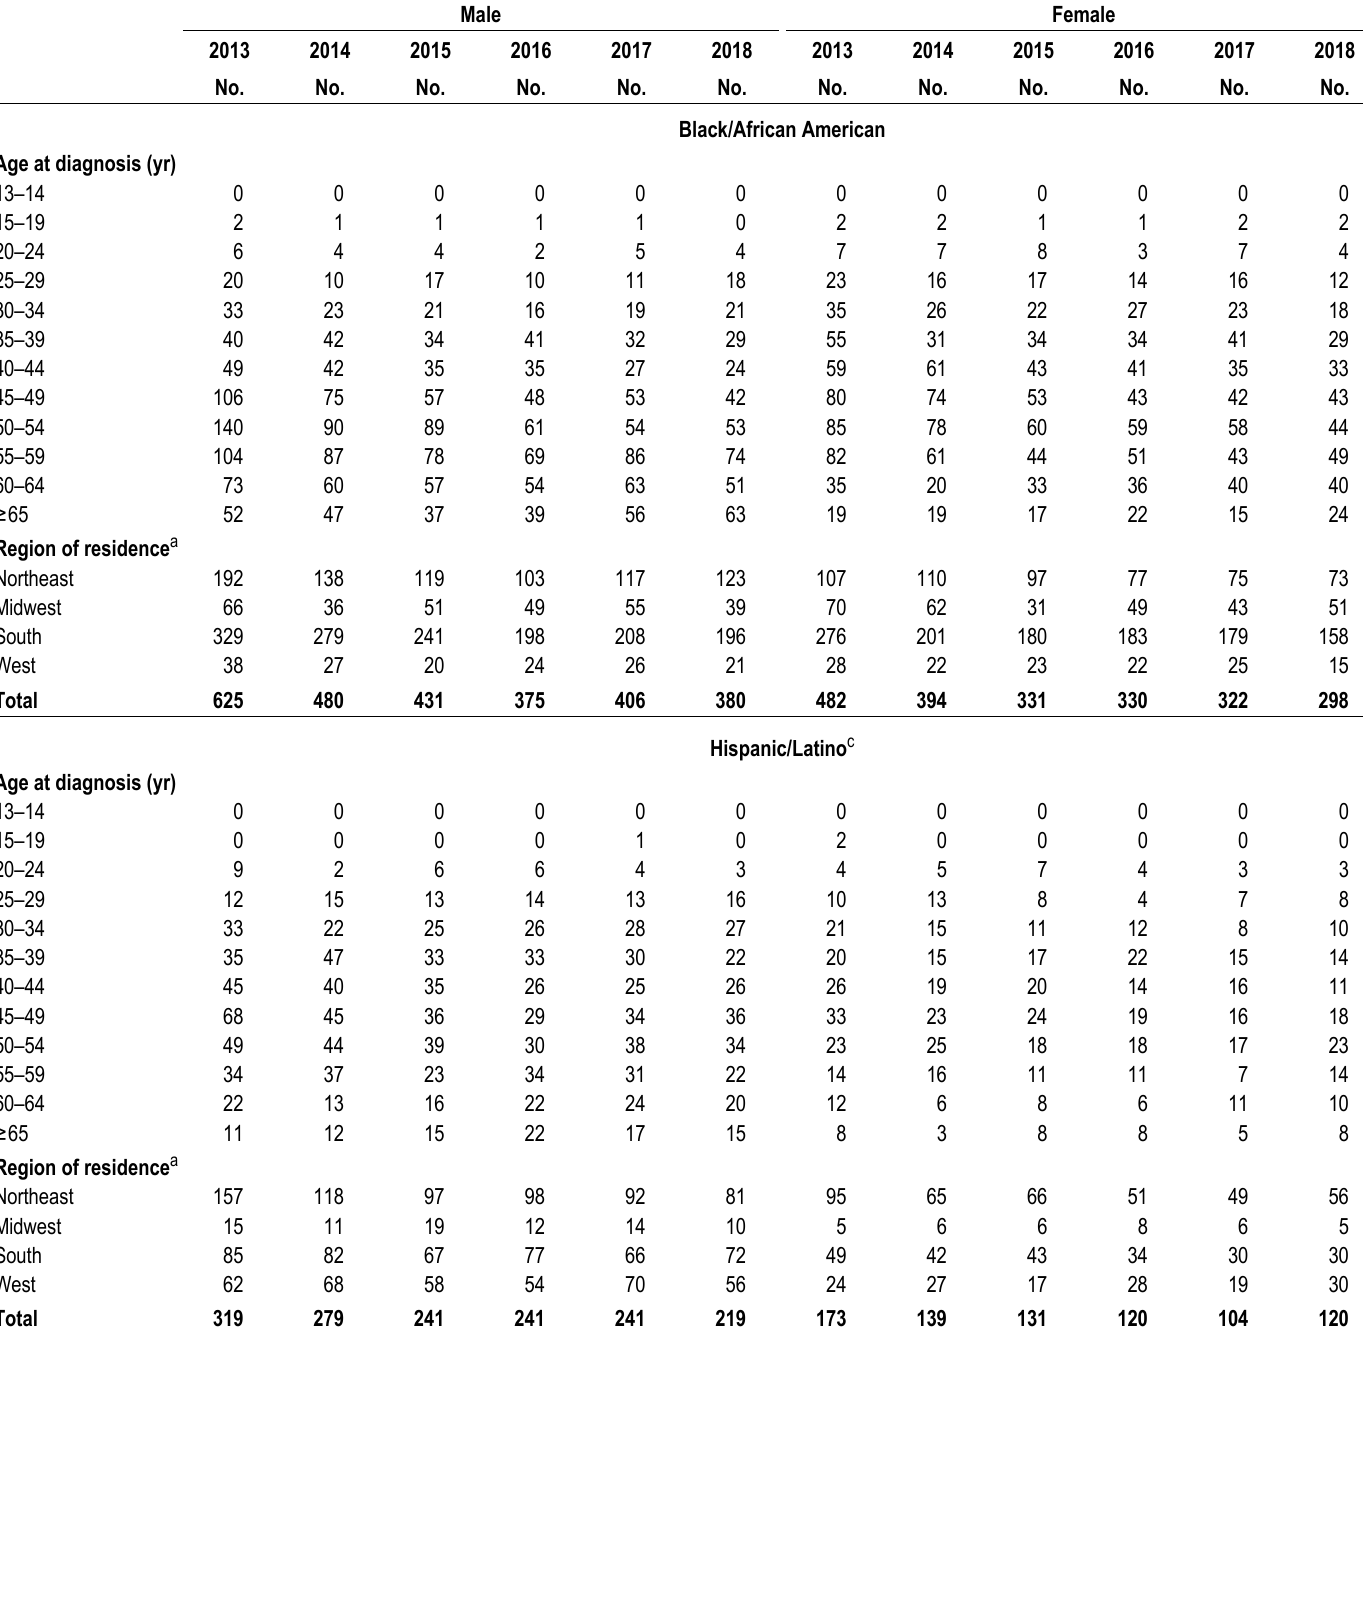
Table 11a. Stage 3 (AIDS) attributed to injection drug use, by selected characteristics, 2013–2018—United States (cont)